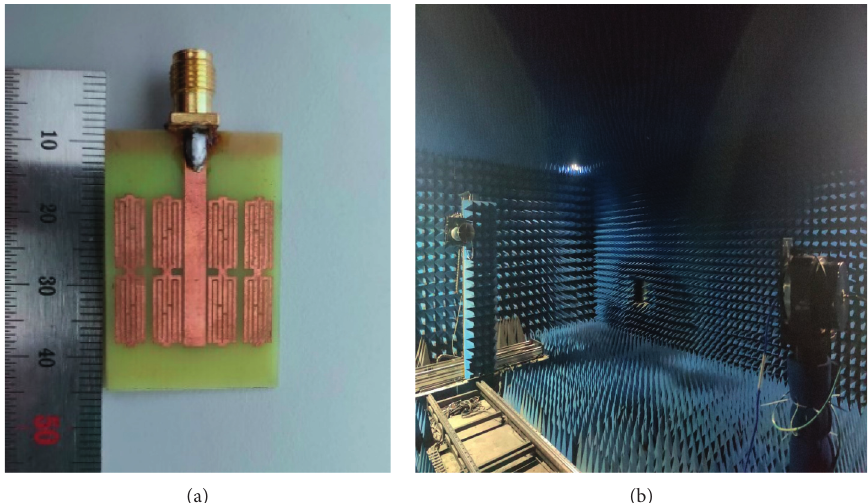
Figure 5: Prototype of the proposed antenna and the measurement environment: (a) prototype of the proposed antenna and (b) measurement environment.